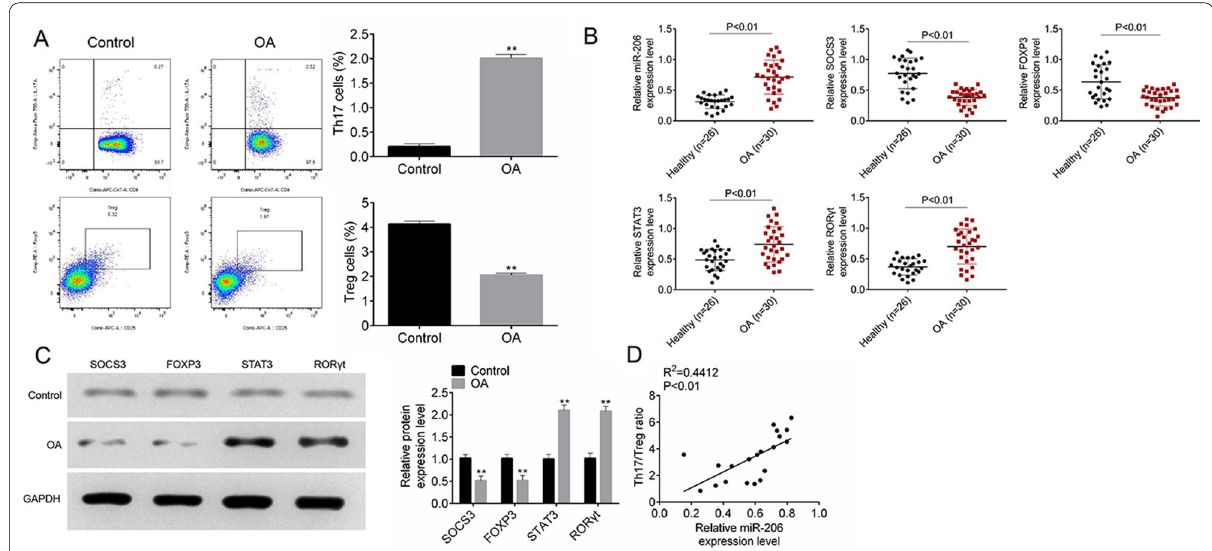
Fig. 1 MiR-206 expression was correlated with Th17/Treg imbalance in patients with OA. The frequencies of Th17 and Treg cells ( A ), quantitative RT-PCR analyses of miR-206, SOCS3, Foxp3, STAT3, RORγt expression ( B ), and western blot analysis of SOCS3, Foxp3, STAT3 and RORγt protein levels ( C ) in PBMCs of OA patients and healthy controls; the correlation of miR-206 with Th17/Treg ratio in PBMCs of OA patients ( D ). All experiments were repeated three times. Data are expressed as mean SD. ** P < ±